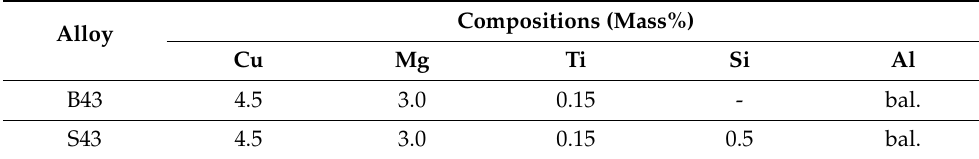
Table 1. Nominal composition of the alloys that were investigated. Compositions (Mass%) Alloy Cu Mg Ti